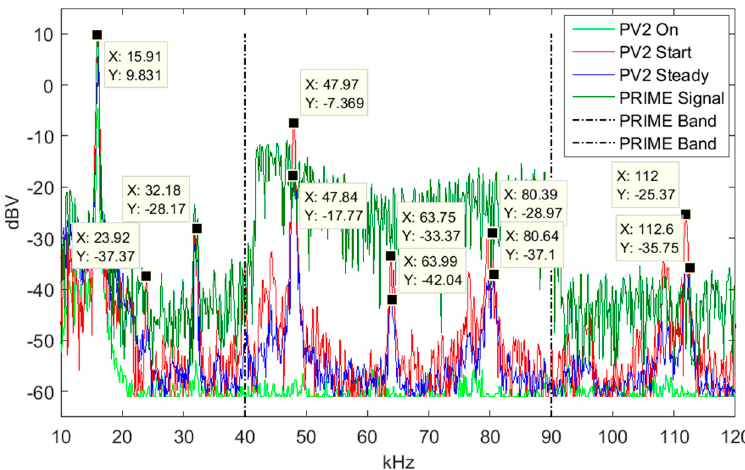
Figure 23. Spectrum recorded at PV2 inverter SM with the rest of inverters switched on and the battery charger disconnected.